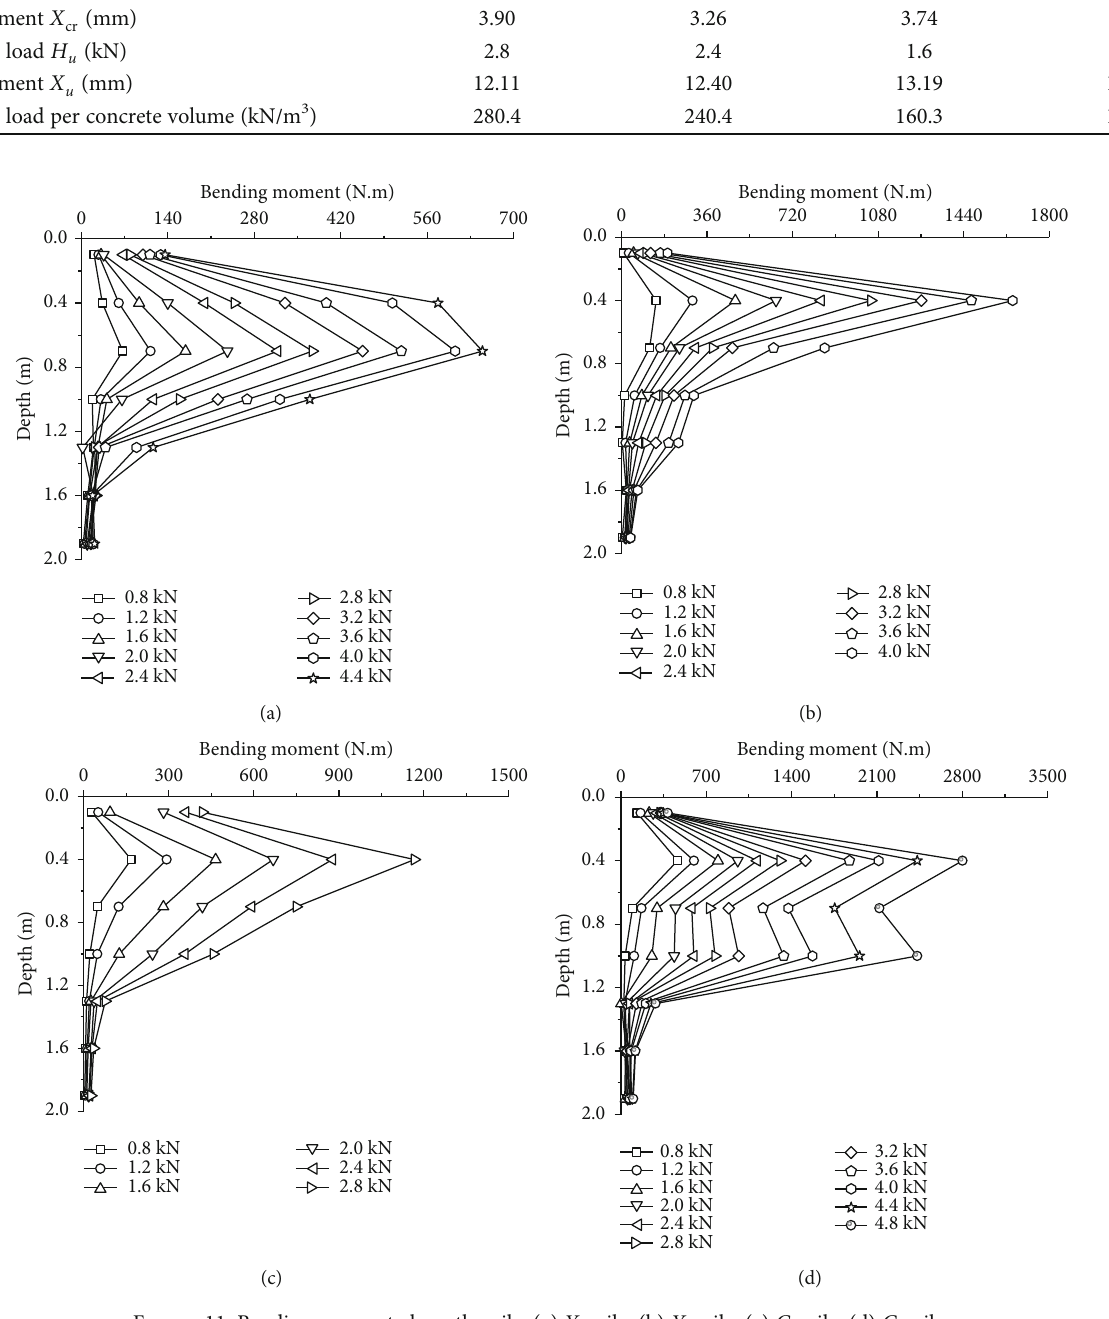
pile; (b) Y pile; (c) C pile; (d) C 1 2 1 2